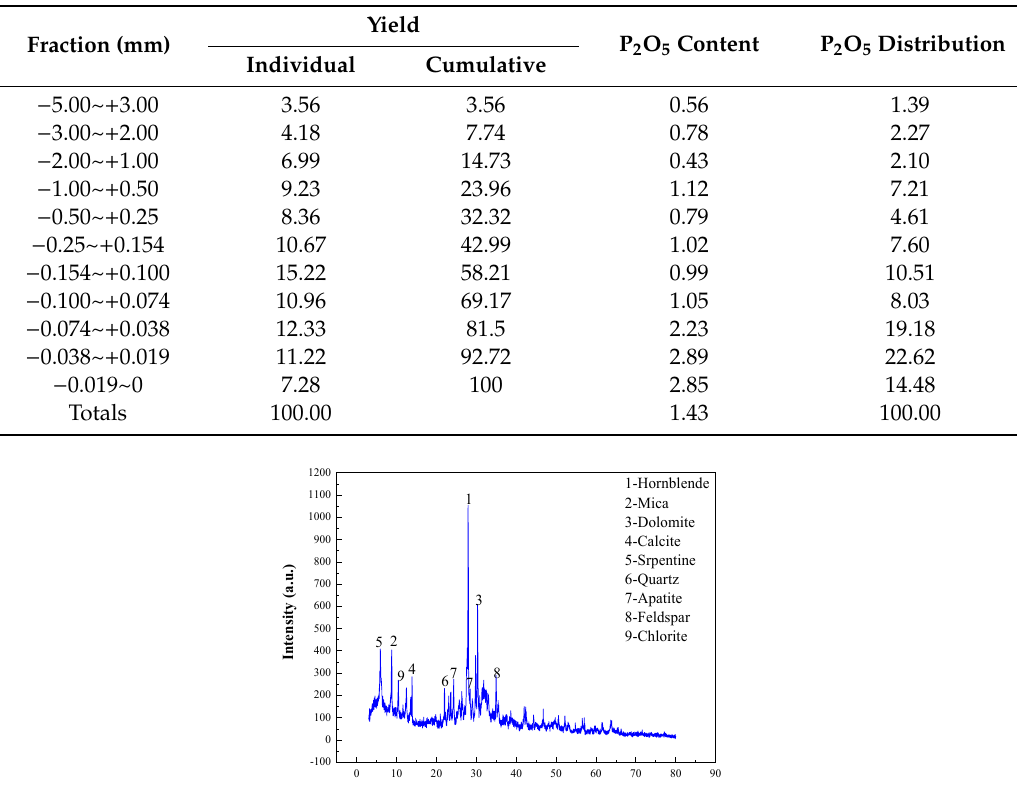
Table 2. A grain size analysis of the P–Containing V–Ti magnetite tailings (%). Yield Fraction (mm)